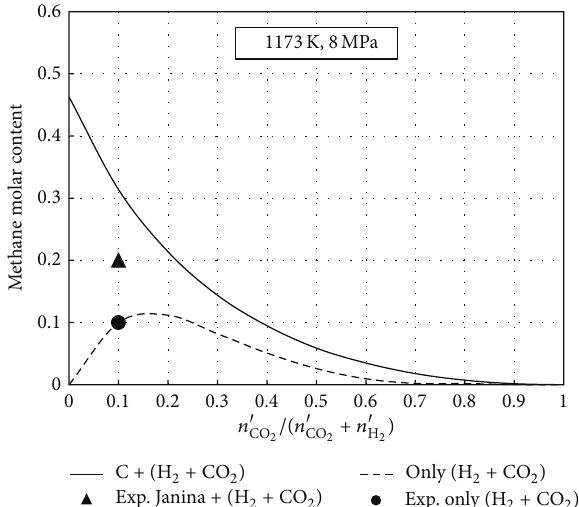
Figure6:CH 4 molarfractioninthehydrogasificationproductswith respect to CO 2 content in the inlet